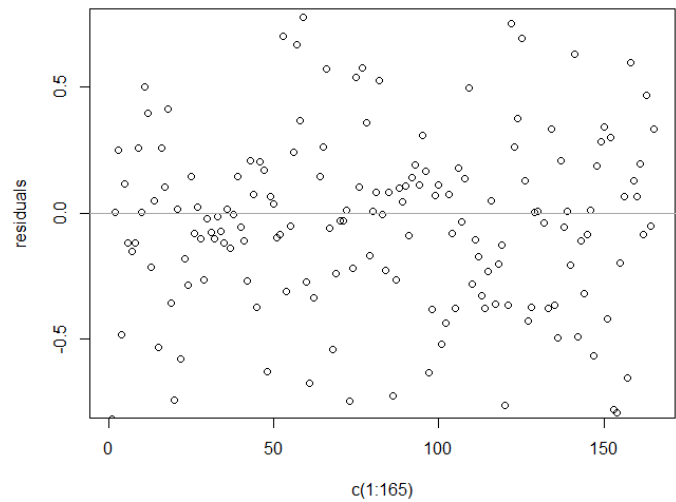
Figure 13. Third-moment Catoni regression residual plot for cell